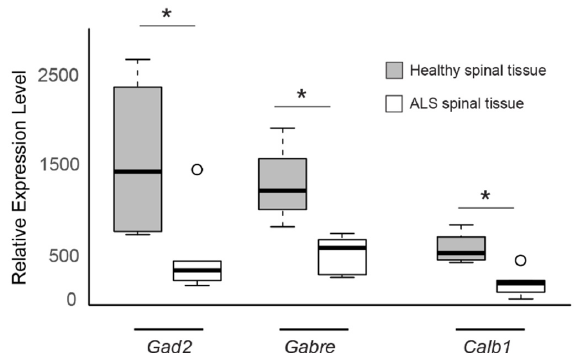
Figure 3. The expression levels of GAD2, GABRE, and CALB1 genes are low in sporadic ALS-spinal tissue. Boxplot comparisons of relative gene expression level of GAD2, GABRE, and CALB1 in GSE833, comparing expression in control spinal neurons and ALS-affected spinal neurons. Boxes are interquartile ranges. Bars are the non-outlier range as defined by R software (version 3.6.1, R Foundation for Statistical Computing, Vienna, Austria). *p< 0.05.